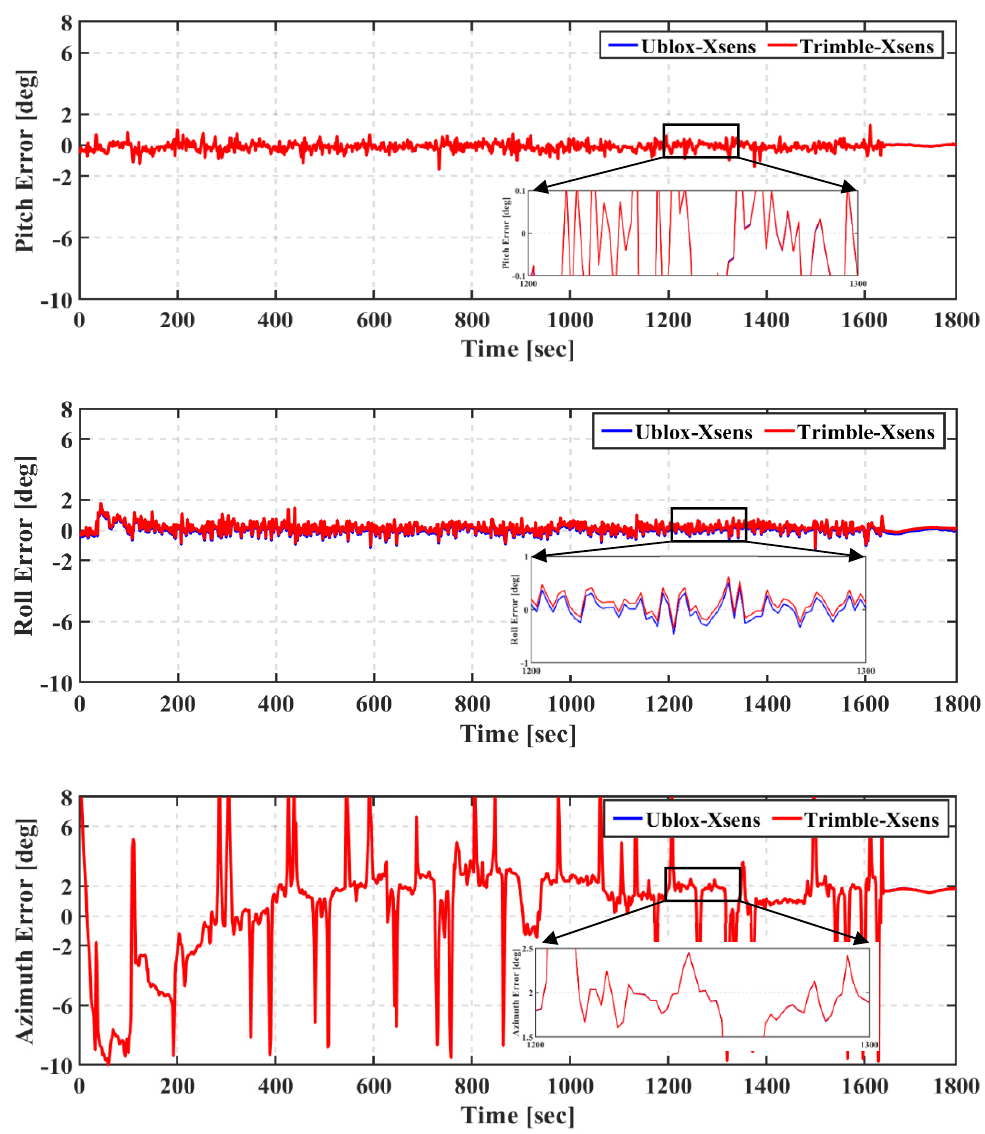
Figure 8. First field trial: Pitch ( top ), roll ( middle ), and azimuth ( bottom ) of real-time TC GNSS PPP/INS for Ublox–Xsens and Trimble–Xsens solutions.